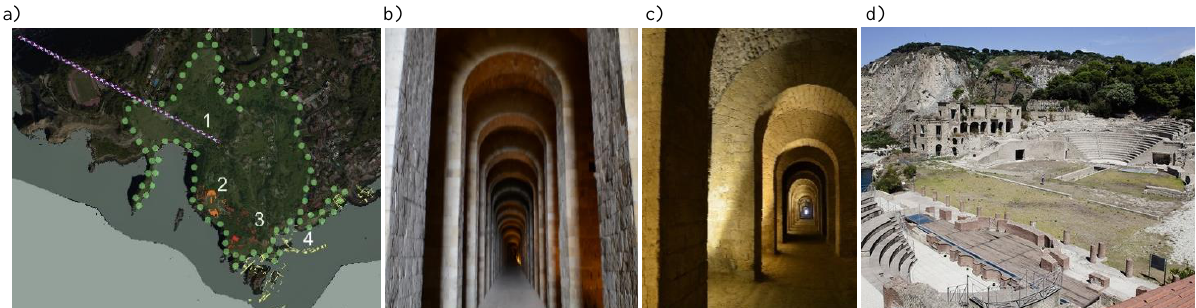
Figure 1: a) The archaeological site of Pausilypon (1: Grotta di Seiano; 2: Theatres area; 3: Other structures covered by vegetation; 4: Structures partially or completely submerged); b-c) Grotta di Seiano; d) Theatres